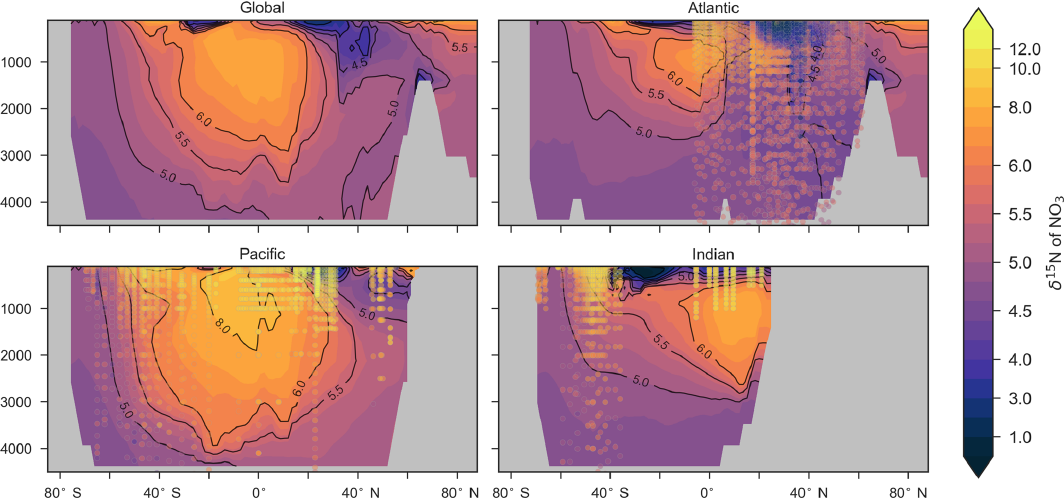
Figure 9. Zonally averaged sections of modelled (colour contours) and observed (overlaid markers) δ 15 N NO encompasses all